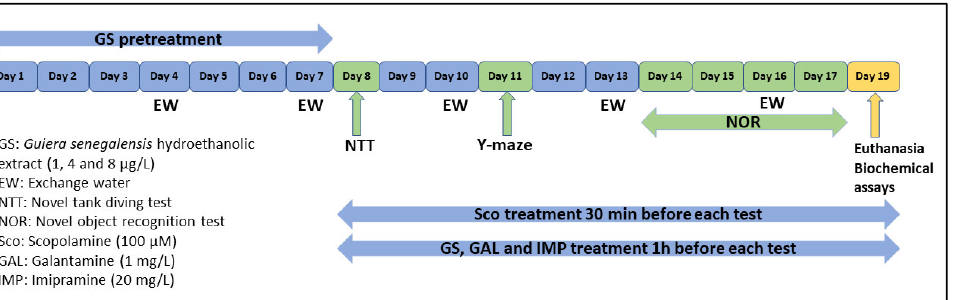
Figure 8. Experimental design procedure for drug administration behavioral study (NTT, NOR, and Y ‐ maze test) and biochemical assays.